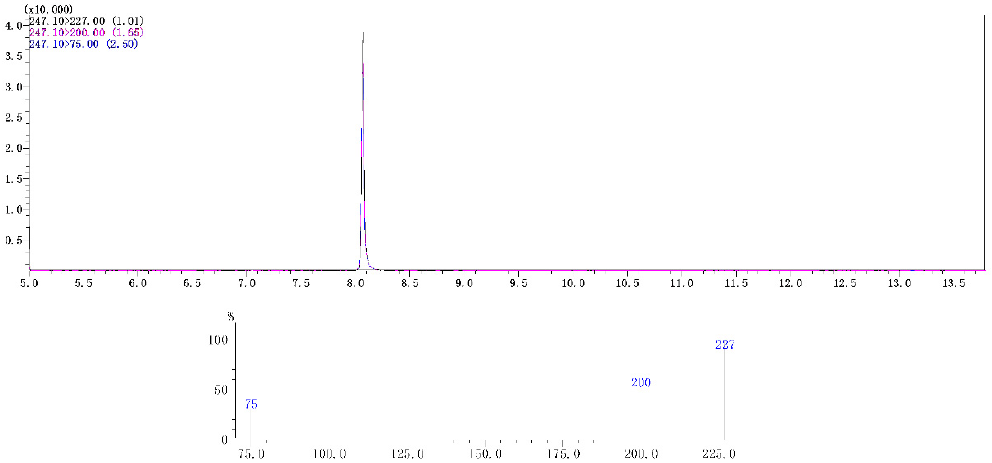
Figure 2. Typical spectra of chlorfenapyr in radish matrix extract detected by GC-MS/MS. The concentration of chlorfenapyr was 0.1 mg/L.